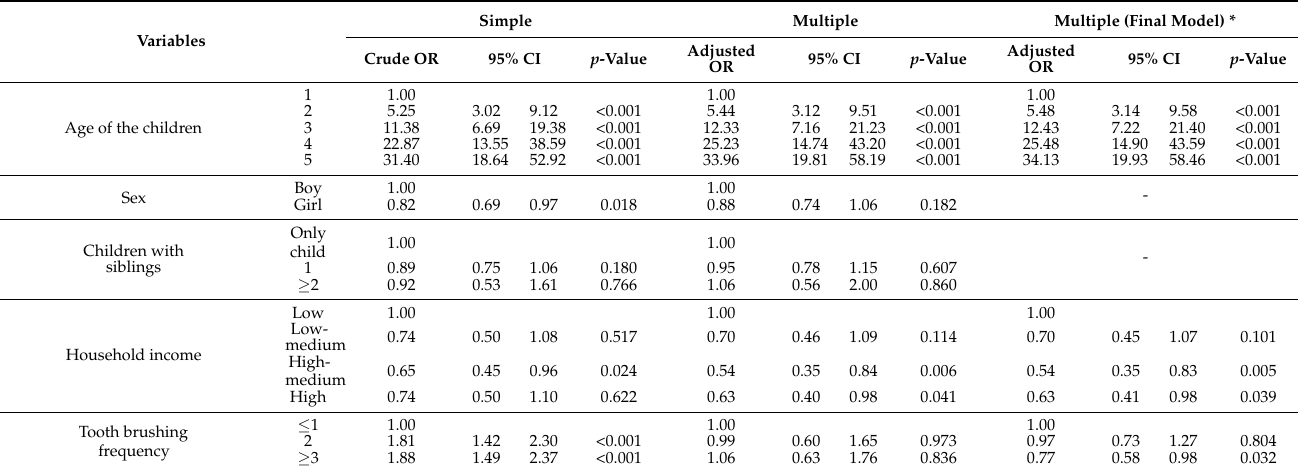
Table 3. Logistic regression results for the prediction of early childhood